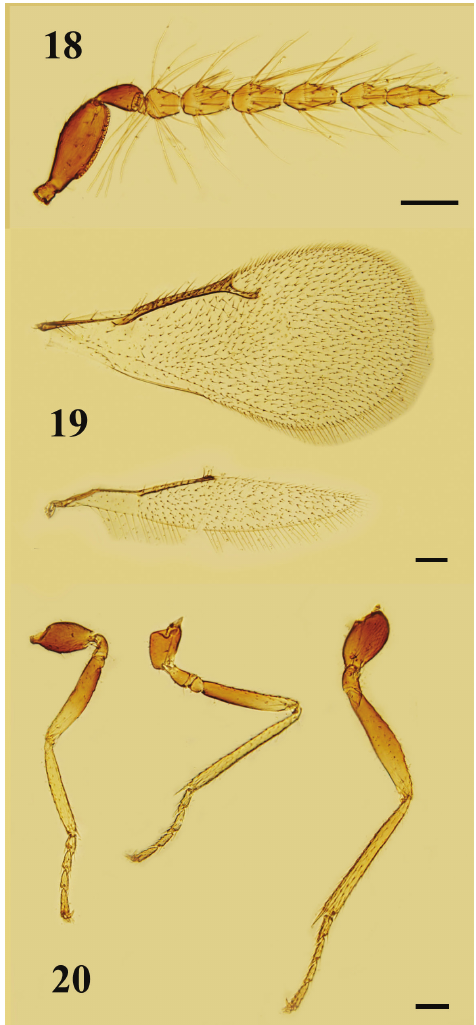
Figures 18–20. Holcotetrastichus rhosaces (Walker), male 18 antenna, lateral view 19 fore and hind wings, dorsal view 20 legs, lateral view, from left to right: fore, mid, and hind legs. Scale bars: 100